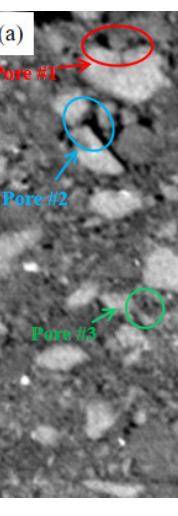
Figure 6. Slice images of the ore sample A and C before and after leaching. ( a ) A D = 2 . 03 Before leaching ; ( b ) A D = 2 . 03 After leaching ; ( c ) C D = 2 . 43 Before leaching ; ( d ) C D = 2 . 43 After leaching .